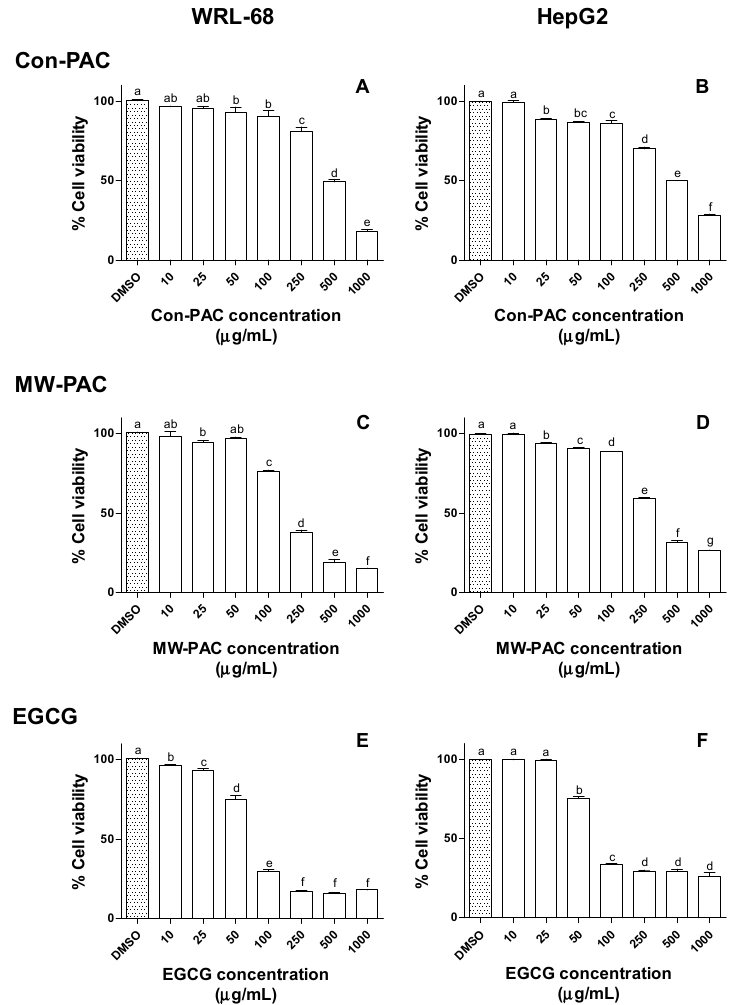
Figure 5. Cell viability (%) of WRL-68 and HepG2 cells exposed to di ff erent concentrations of Con-PAC, MW-PAC, and EGCG measured by MTS cell viability assay. WRL-68 and HepG2 cells were exposed to 10–1000 µ g / mL concentrations of Con-PAC ( A and B , respectively), MW-PAC ( C and D , respectively), and EGCG ( E and F , respectively) for 24 h. Cell viability of the WRL-68 and HepG2 cells was measured by incubating (3 h at 37 ◦ C) the cells with MTS cell viability reagent. Results presented are means ± SD of three independent experiments. Means sharing the same letter are not significantly di ff erent at the 5% level. Con-PAC: PACs extracted by conventional method; MW-PAC: PACs extracted by microwave-assisted method; EGCG, epigallocatechin gallate.